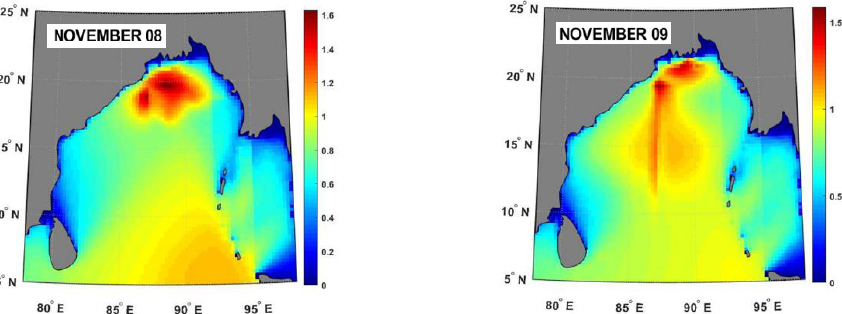
Figure 15. Computed SWH (m) for BULBUL cyclone on 8th and 9th November using SCATSAT − 1 daily 25 km wind data.